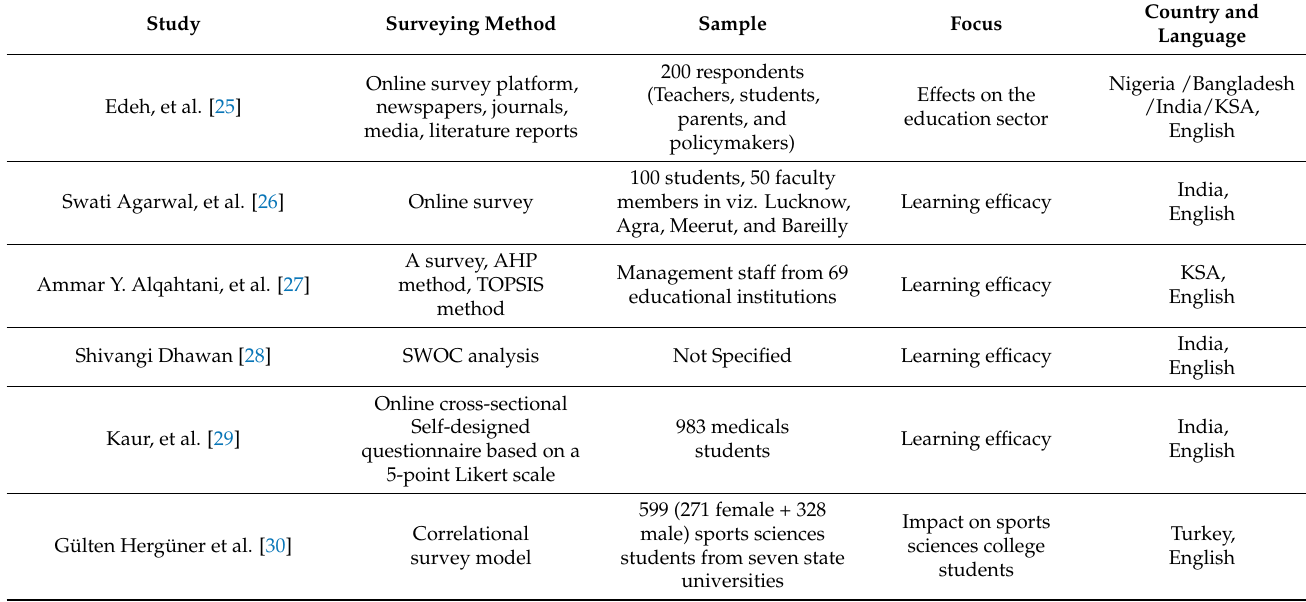
Table 1. Comparison of literature related to the impact of COVID-19 on education sector using surveying